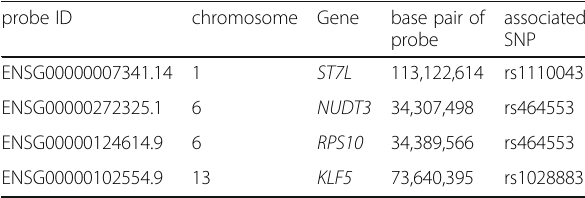
Table 1 Metal SMR of Westra et al. eQTLs and appendicular lean mass GWAS